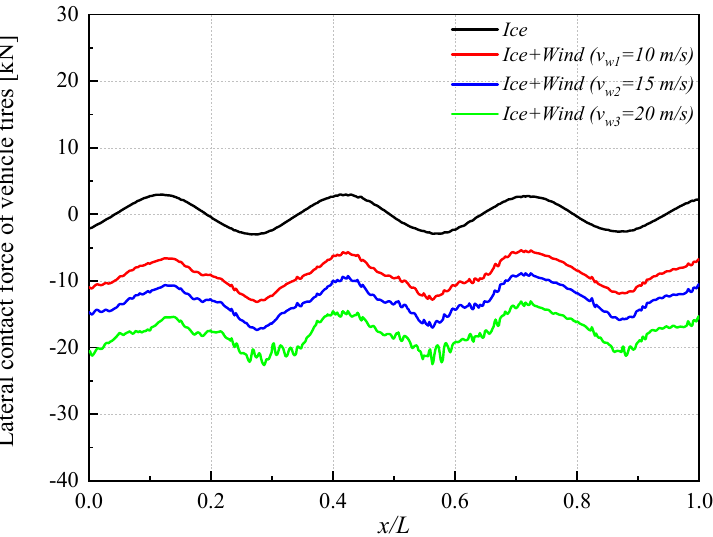
Figure 17. Lateral contact force between tires and bridge deck under combined ice and wind loads. The vertical contact force between vehicle tires and bridge deck under combined ice and wind loads is shown in Figure 18. It can be seen from Figure 18 that the vertical contact force of the vehicle under the combined ice and wind loads is slightly larger than that under the ice load. The vertical contact force of the vehicle is mainly affected by the pavement roughness, but the wind load also has a certain impact on the vertical contact force of the vehicle. With the increase in wind velocity, the vertical contact force of the vehicle increases slightly.